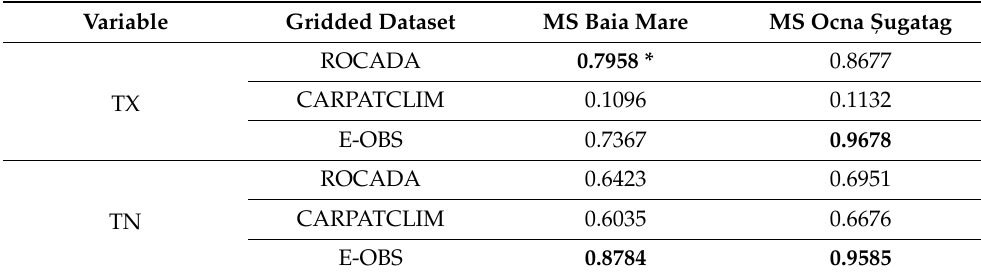
Table 6. Pearson’s correlation coefficient between gridded and observation data series for the 1st percentile of the extreme temperature datasets